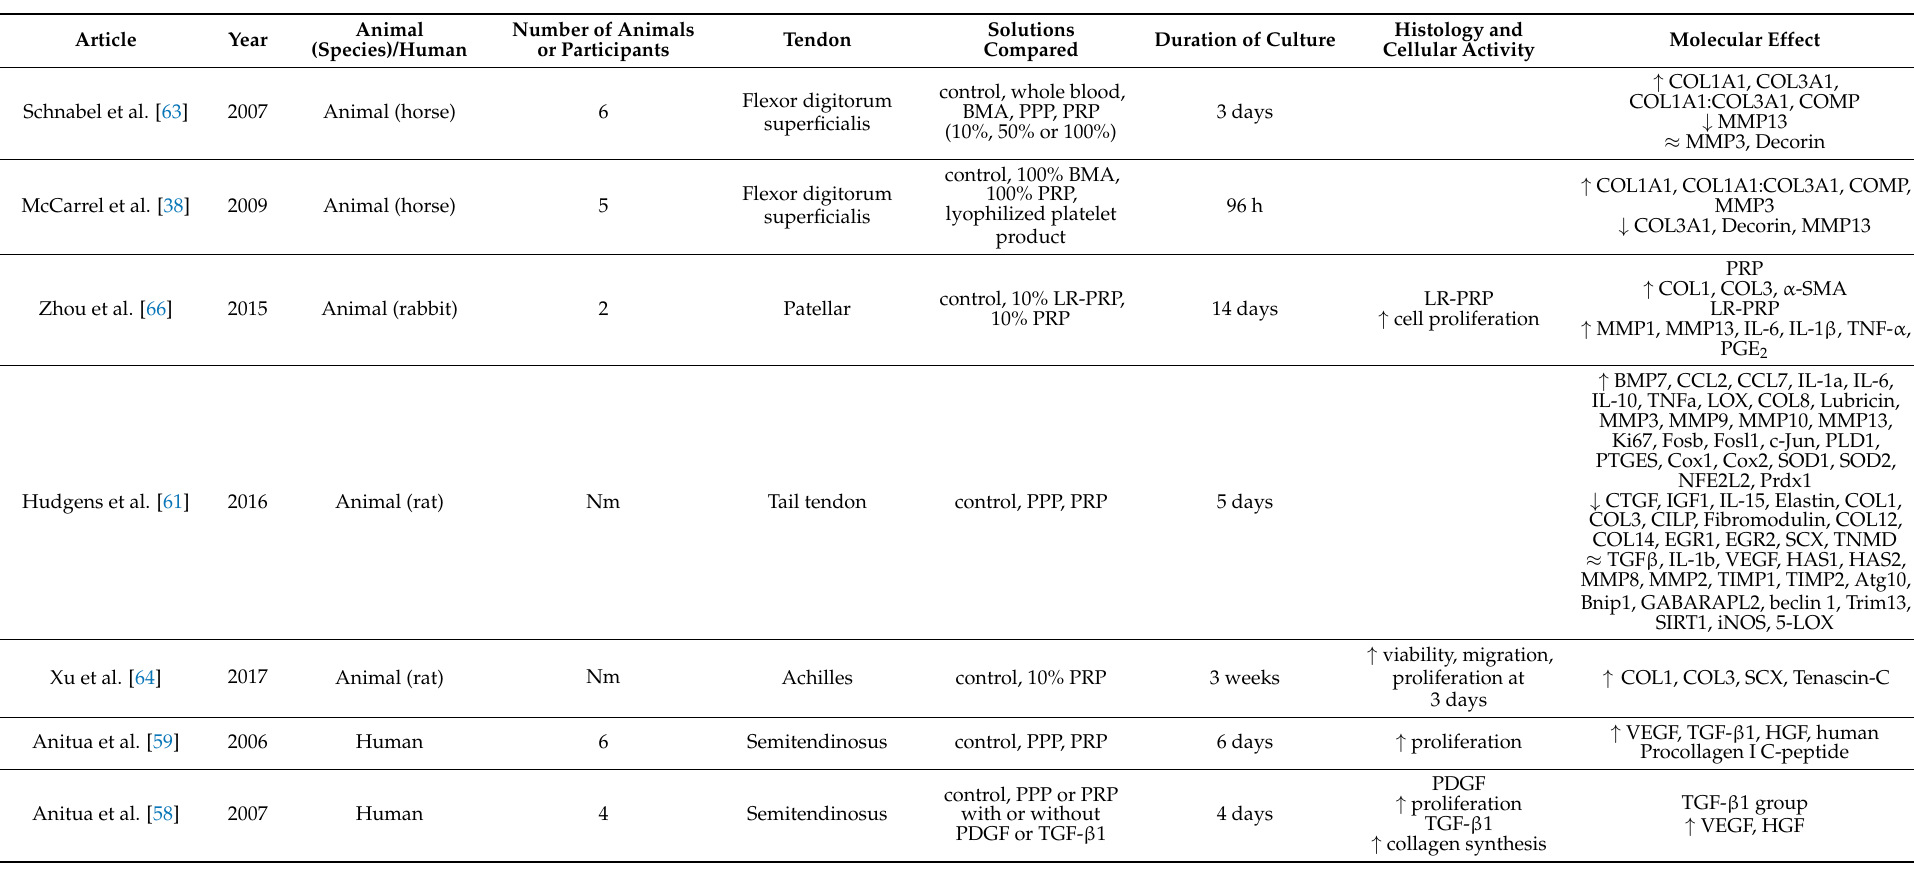
Table 3. Histological and molecular effect of PRP on tendons in in vitro